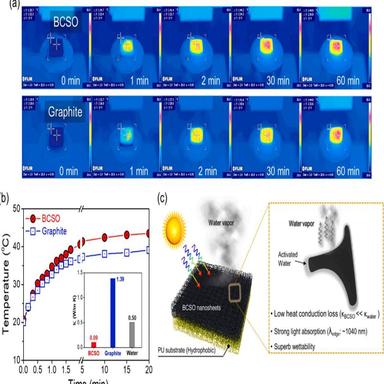
Photothermal behavior of BCSO nanosheets and graphite under simulated sunlight illumination (1 sun): (a) IR images of the photothermal absorber in wet state, (b) Changes in surface temperature with illumination time. (Inset representing the thermal conductivity of BCSO, graphite and water), and (c) Advantages of BCSO nanosheets for solar steam generation and magnified image of BCSO coated PU sponge.